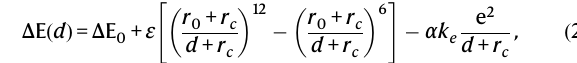
hydrogel. The periodic unit cell (enclosed in the dashed-edged box) contains one CBMA molecule and 40water molecules. The spaces betweenneighboring CBMAs are also fi lled with 40 water molecules. The blue, red, brown, and white colors representtheN,O,C,andHatoms,respectively.Thede fi nitionsof d andrc arealso displayed. f TheformationofCOOHandonemobileOH − ensureaneutralchargein this system. g Plots of Δ E( d ) versus distance d between N(CH 3 ) 3+ and COO − on neighboring CBMA segments. The red solid line is fi tted to Eq. (2) in the main text. h Plots of the L – J 12-6 and Coulomb terms versus d (black and red solid lines, respectively). The dashed line represents the energy at in fi nite d